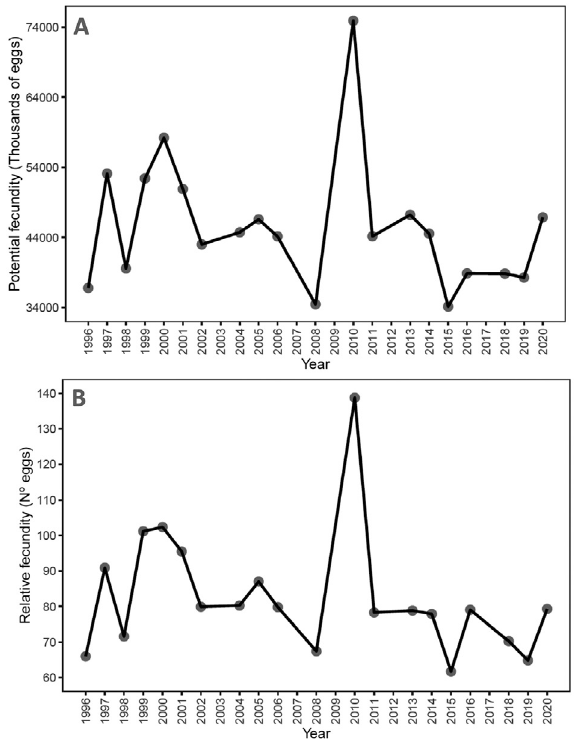
Fig. 5. – Temporal variation in potential fecundity (A) and relative fecundity (B) between 1996 and 2020 for a 34 cm S. fasciatus female.